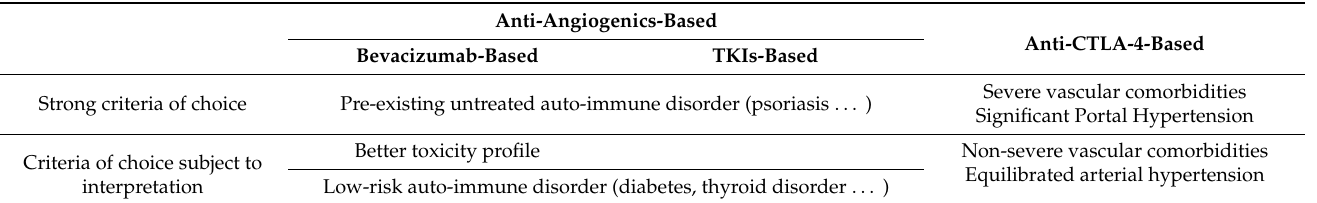
Table 2. Potential criteria for the choice of future first-line treatment. Anti-Angiogenics-Based Bevacizumab-Based TKIs-Based Pre-existing untreated auto-immune disorder (psoriasis . . . )